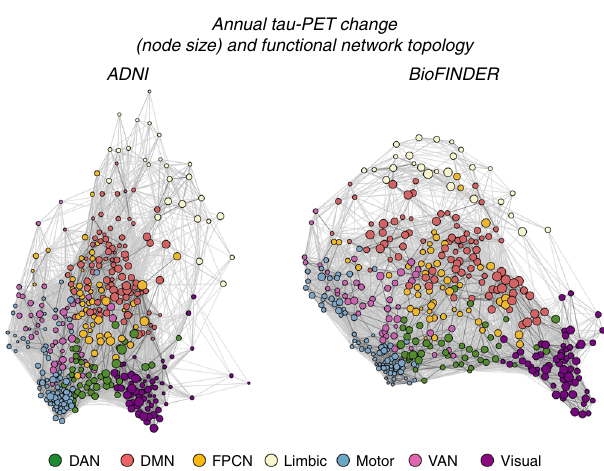
Fig. 5 Tau-PET change and functional network topology. Force-directed graphs illustrating ROI-speci fi c annual tau-PET change in the A β + (node size) subjects (ADNI, N = 53, left panel; BioFINDER, N = 41, right panel) within the context of functional connectivity (node distance, de fi ned based on the Fruchtermann-Reingold algorithm applied to group-average functional connectivity